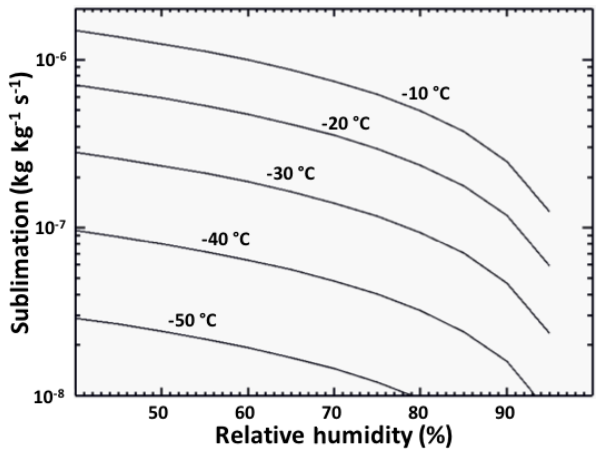
Figure 4. Computed blowing snow sublimation rate using Eq. (6) as a function of relative humidity for varying air temperatures. The particle density value used in Eq. (6) was 10 6 m − 3 , which corre- sponds to a blowing snow mixing ratio ( qb ) of 4.7 × 10 − 5 kgkg − 1 .